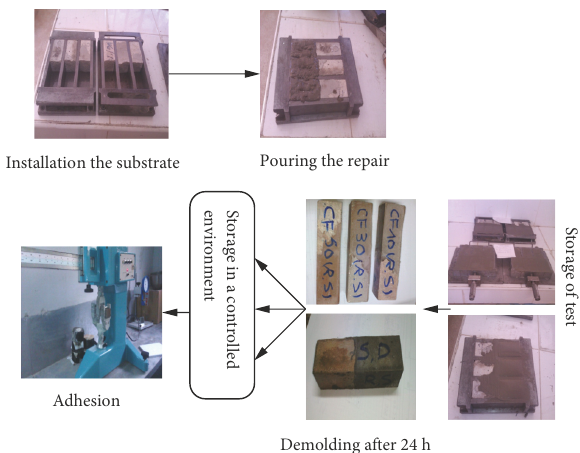
Demolding after 24 h Figure 3. The manufacturing steps of the specimens